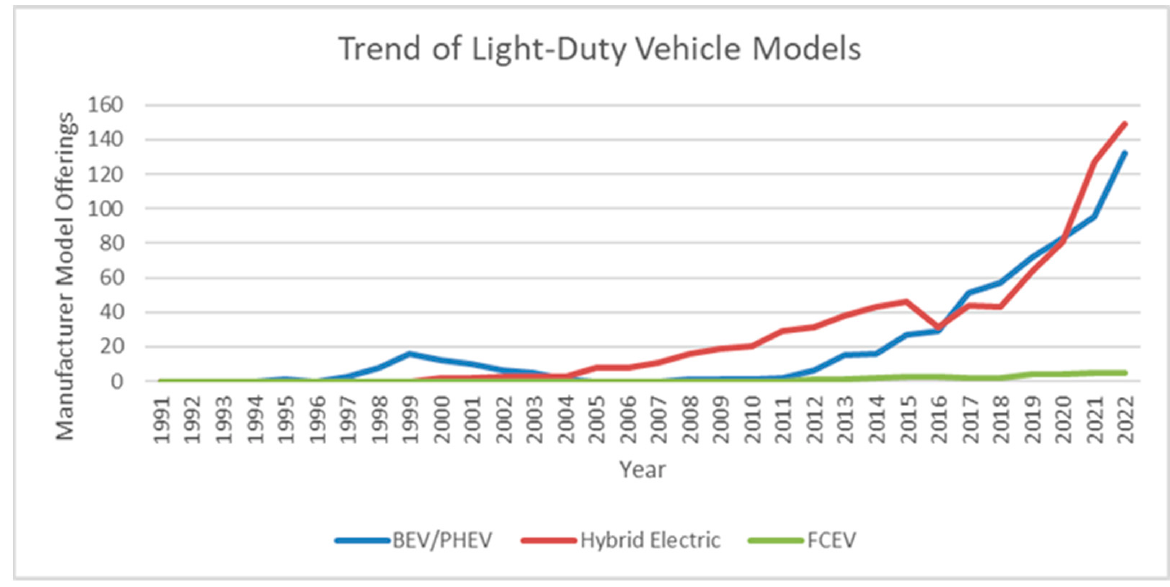
Figure 2. Yearly trends of EV models offered by vehicle manufacturers from 1991 to 2022.